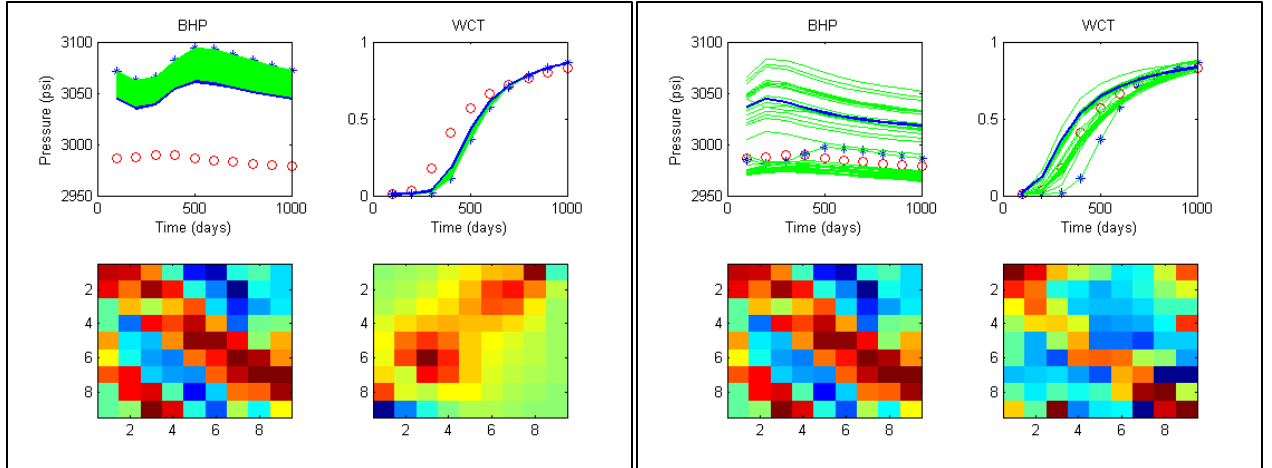
Figure 11—Comparison of history matching process between α=0.01 and 3.